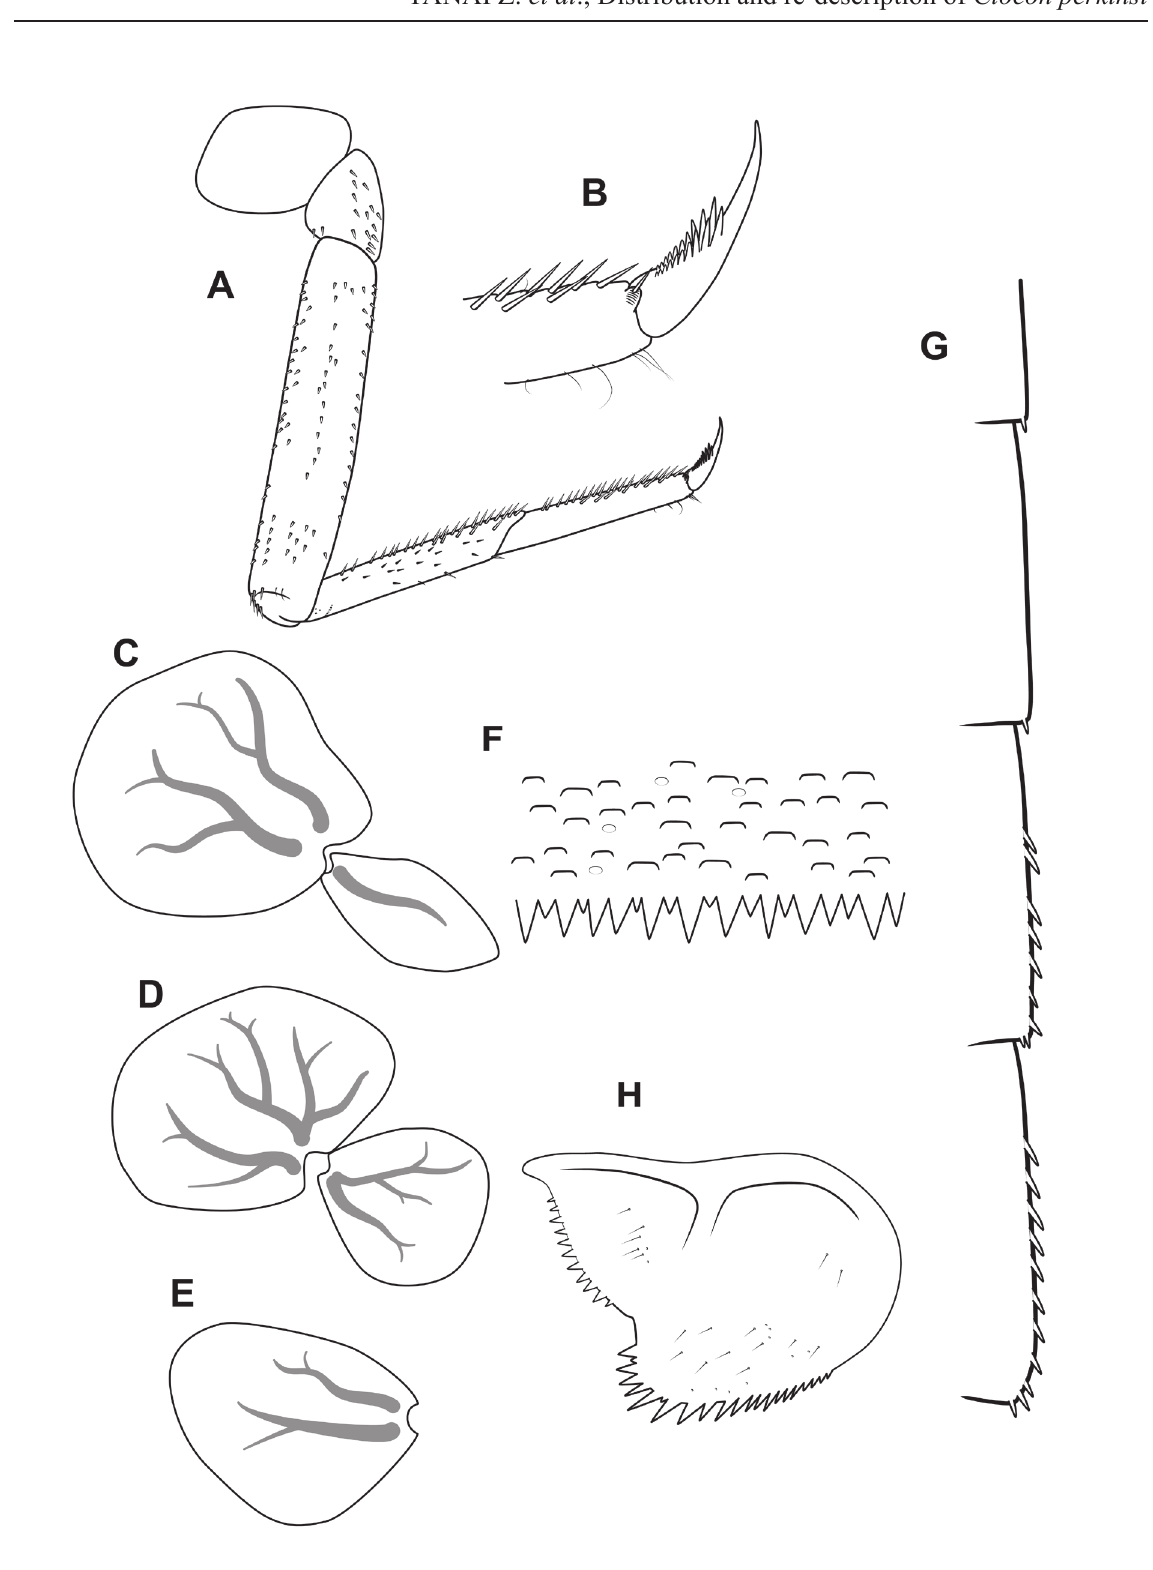
Fig. 6. Cloeon perkinsi , nymph. A . Foreleg. B . Tarsal claw. C . Gill I. D . Gill IV. E . Gill VII. F . Abdominal tergum V, surface and distal margin. G . Lateral abdominal margins (segments VI, VII, VIII, IX). H . Paraproct